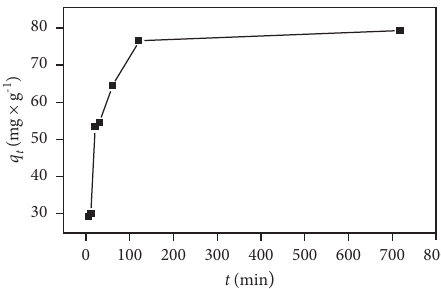
Figure 4: The curves of Cr (VI) adsorbed by Cu (I)-MOF at different times in aqueous solution.